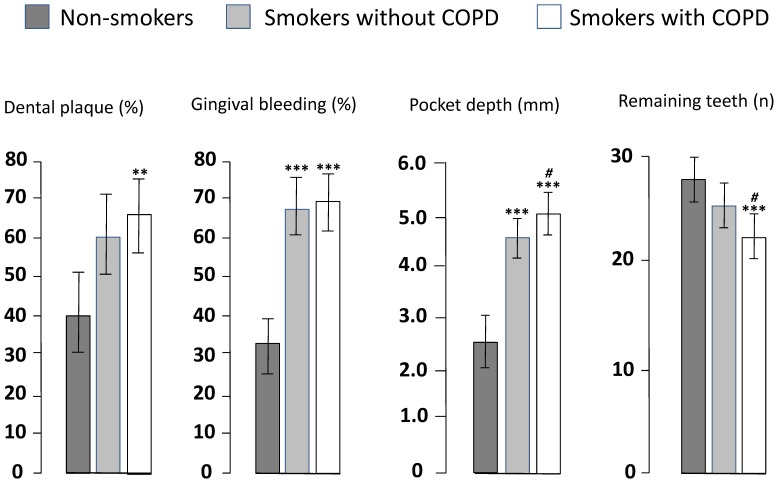
Dental plaque, gingival bleeding, pocket depth and remaining teeth in 28 smokers with COPD, 29 smokers who did not fulfill the criteria for COPD, matched for smoking, and 23 healthy non-smokers.Mean values and 95% confidence intervals. There is an overall difference between the groups for all outcomes (dental plaque p<0.01, gingival bleeding p<0.001, pocket depth p<0.0001, remaining teeth p<0.001). **and ***indicate p<0.01 and p<0.001, respectively compared with non-smokers. # indicates p<0.05 compared with smokers without COPD.